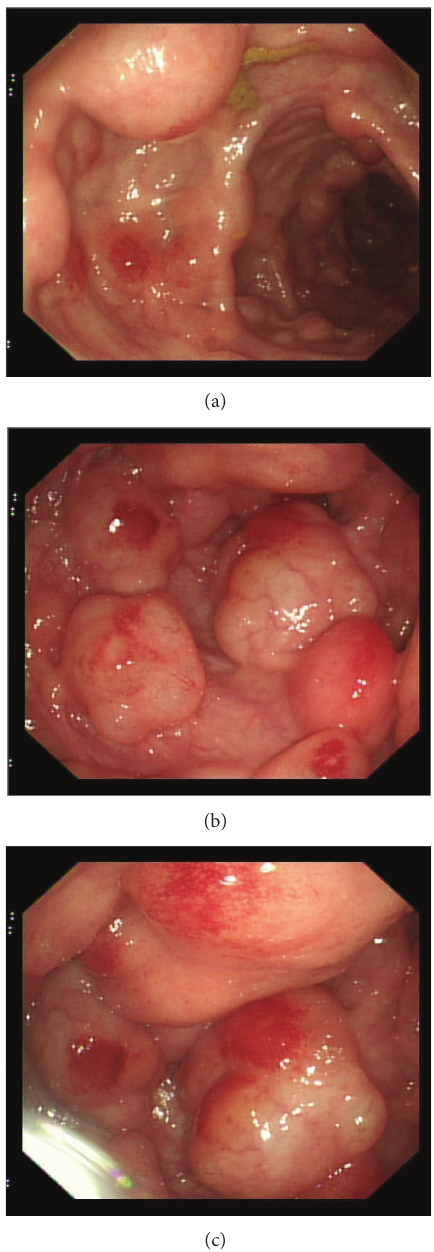
Figure 1: Multiple colonic polyps identified endoscopically within the sigmoid colon.